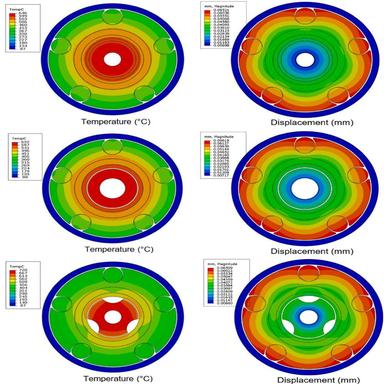
Shows top-down cross-section views of the IMPACT capsules with resulting temperatures (left) (◦C) and displacement due to thermal expansion (right) in mm.